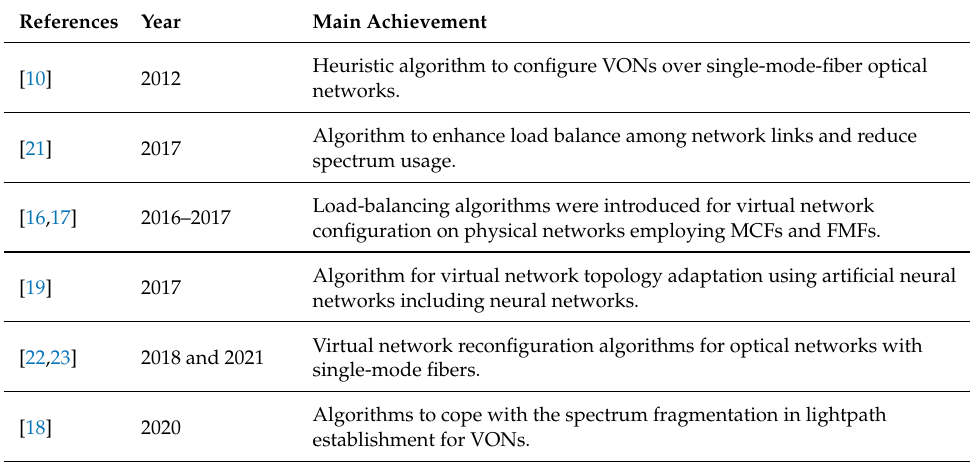
Table 1. Existing solutions in the